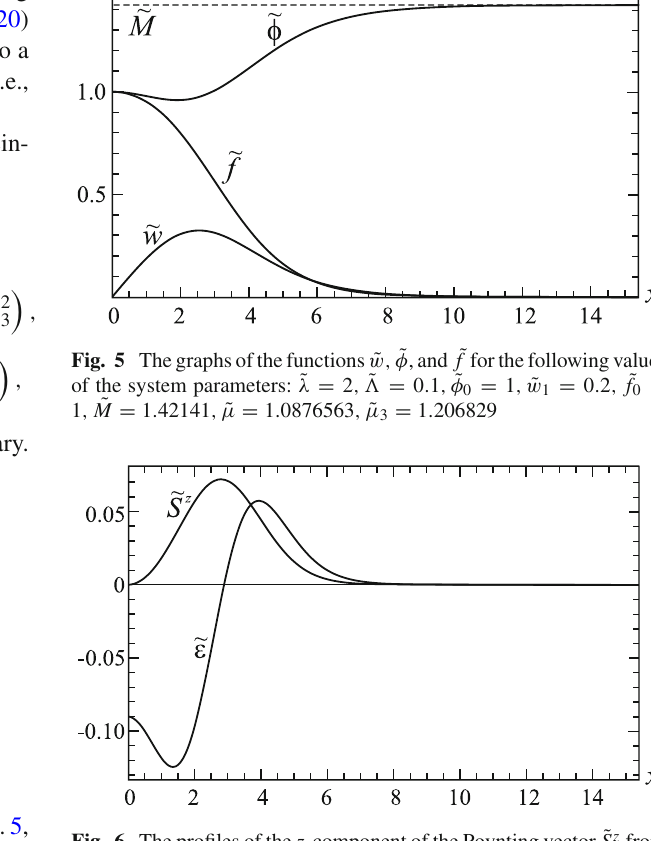
Fig. 6 The profiles of the z -component of the Poynting vector ˜ S z from Eq. (25) and of the energy density ˜ ε from Eq. (24)